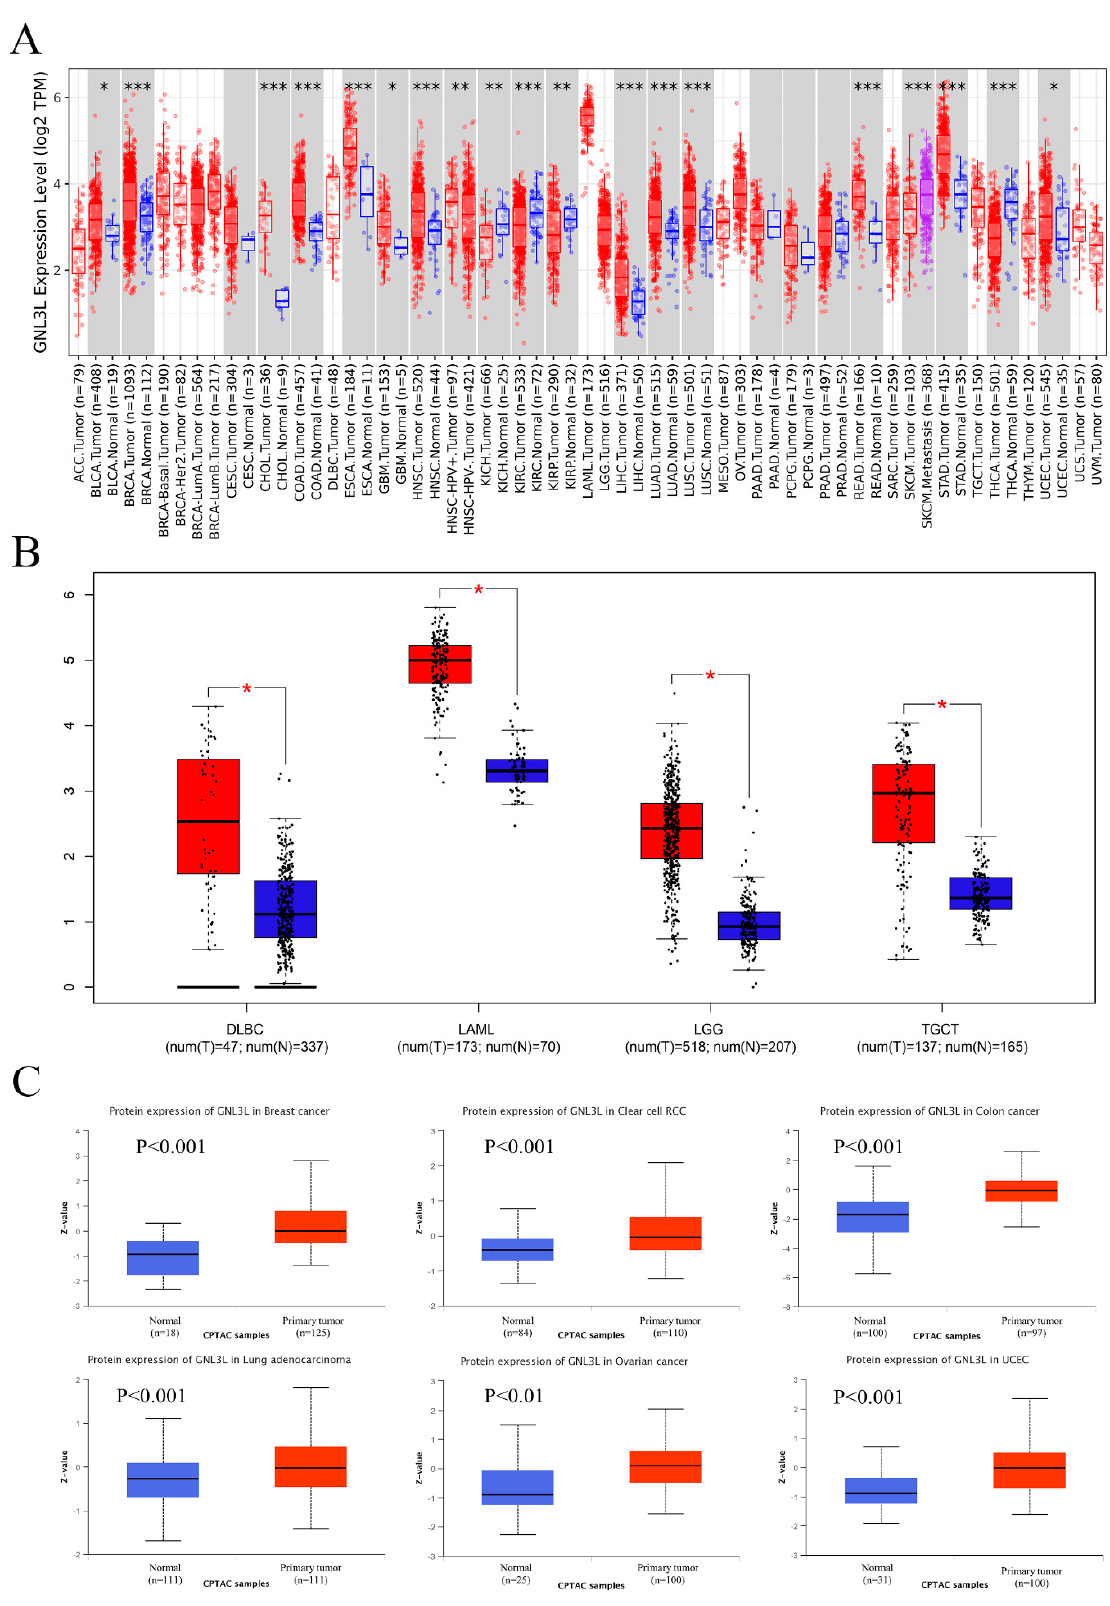
Figure 1. GNL3L gene expression levels and protein expression levels. Red represents patient samples and blue represents normal samples. ( A ) Expression of GNL3L gene in ACC, BLCA, BRCA, BRCA − Basal, BRCA − Her2, BRCA − LumA, CESC, CHOL, COAD, DLBC, ESCA, GBM, HNSC,